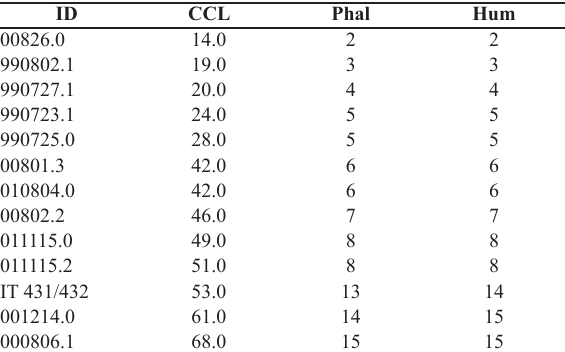
Table 1. Number of visible LAGs in phalanx (phal) and humer- us (hum) sections of Caretta caretta . CCL – curved carapace length (in cm) (reworked from Di Maio et al. 2003, and au- thors’unpublished data).